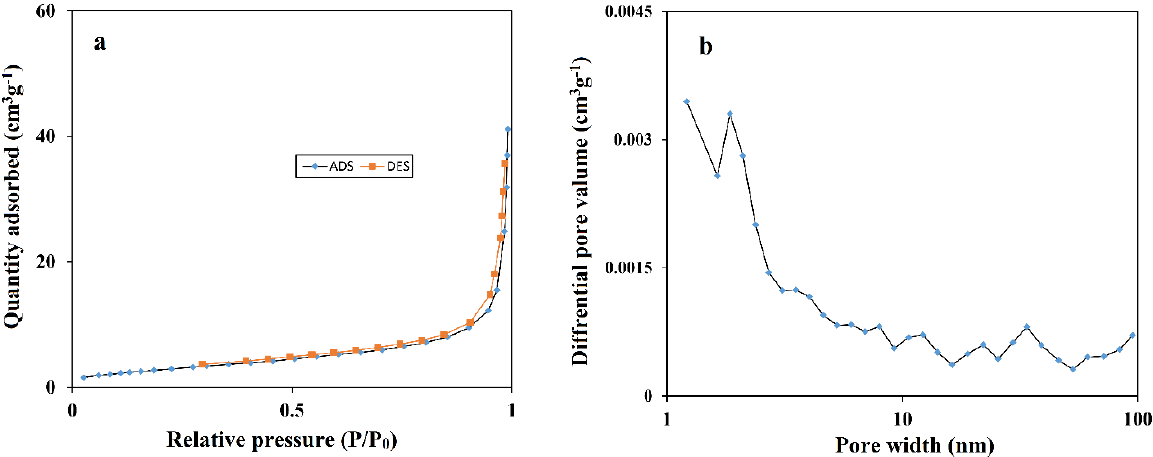
Figure 2. ( a ) N 2 adsorption–desorption isotherms; and ( b ) BJH pore size distribution curve of the CoMOF.